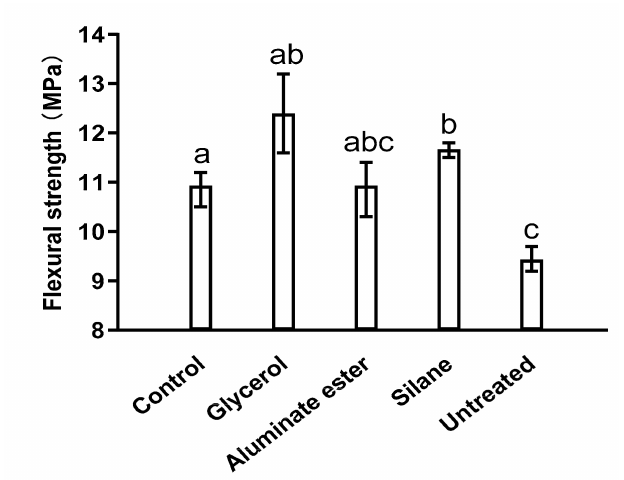
Figure 4. Flexural strength of di ff erent mixtures at 28 d. Note: Data were analyzed with one-way ANOVA. Significant di ff erences exist between any two groups when they do not share a common letter over the columns. (This applies to the following figures.)